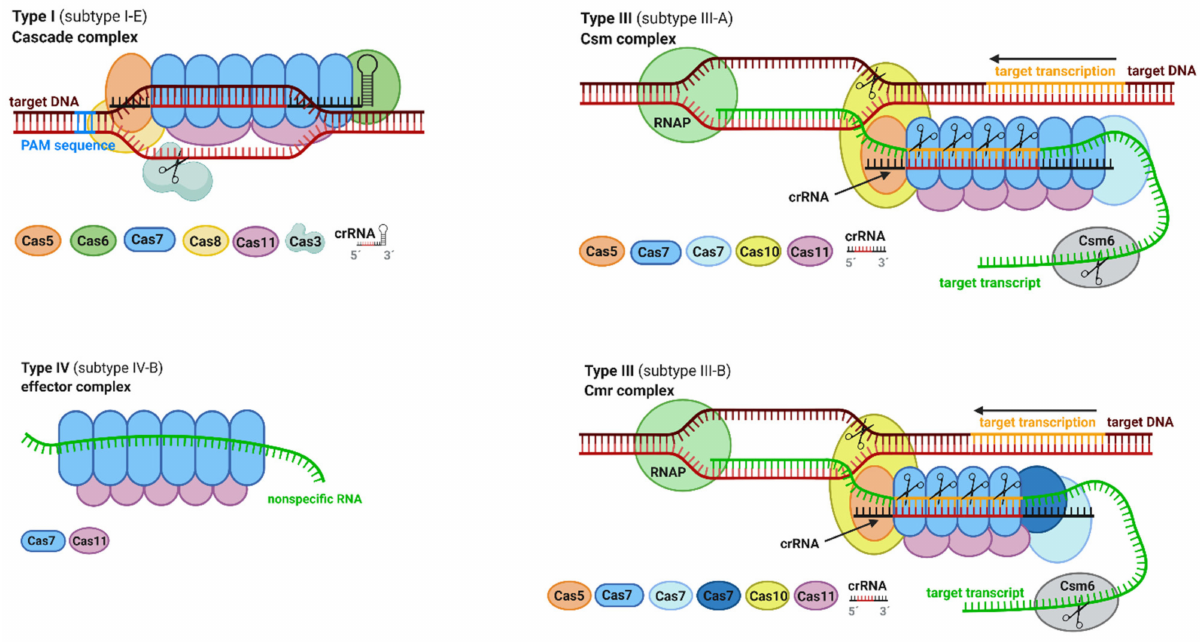
Figure 4. Selected multiprotein effector complexes of CRISPR class 1 systems. Figure was created with BioRender.com (accessed on 15 February